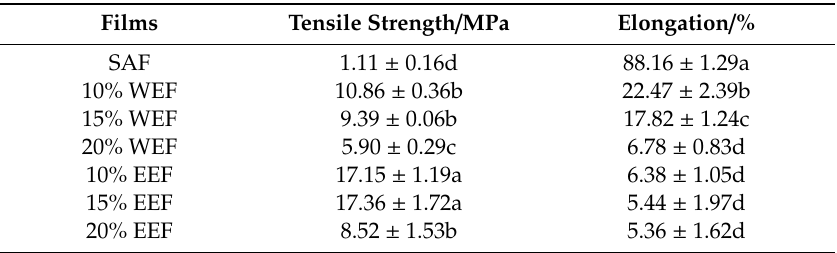
Table 4. Mechanical properties of the films.